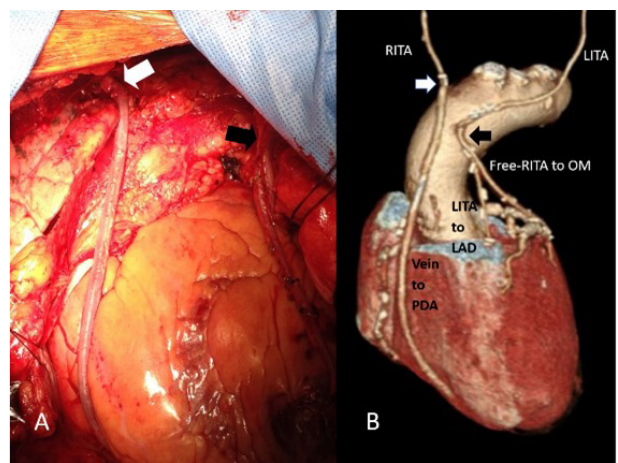
Fig. 1 - A. Proximal anastomosis of the free right internal thoracic artery (RITA) graft to the left internal thoracic artery (LITA) in a Y-fashion (black arrow); saphenous vein graft (SVG) to posterior descending coronary artery (PDA) proximally grafted end-to- end to the RITA stump (white arrow). B. Postoperative computed tomography coronary angiography depicting the end-to-end SVG-RITA stump anastomosis (white arrow) and the free RITA graft proximal anastomosis to LITA (black arrow). LAD=left anterior descending coronary artery; OM=obtuse marginal.